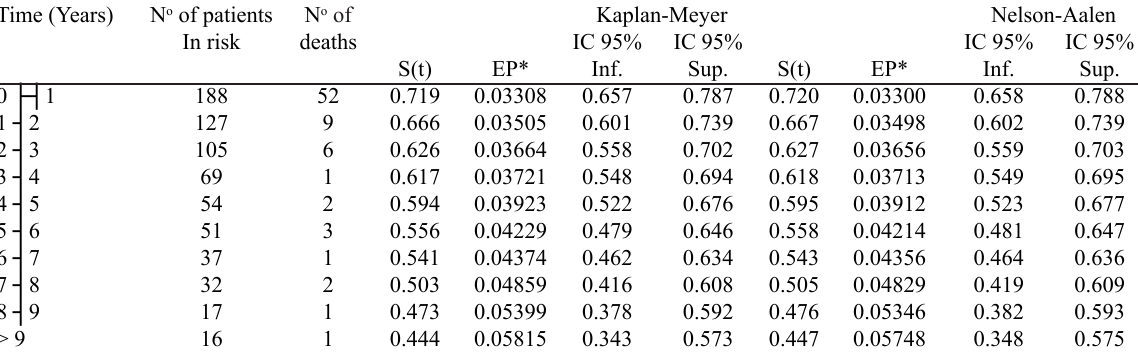
Table 2. Kaplan-Meier Estimators and Nelson-Aalen for the survival time of patients submitted to cardiac transplantation. Fortaleza, Ceará, Brazil.